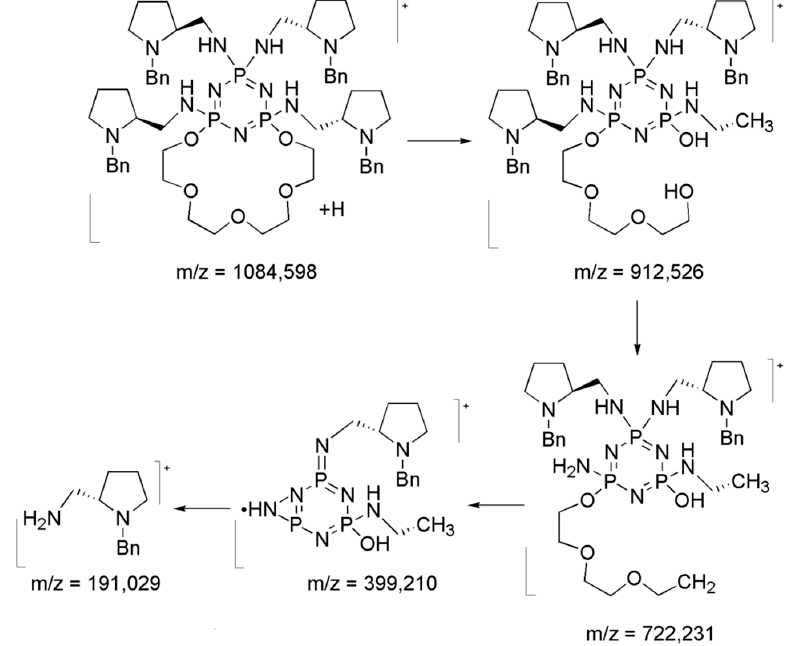
Scheme 7. The second fragmentation pathway of the free ligand .